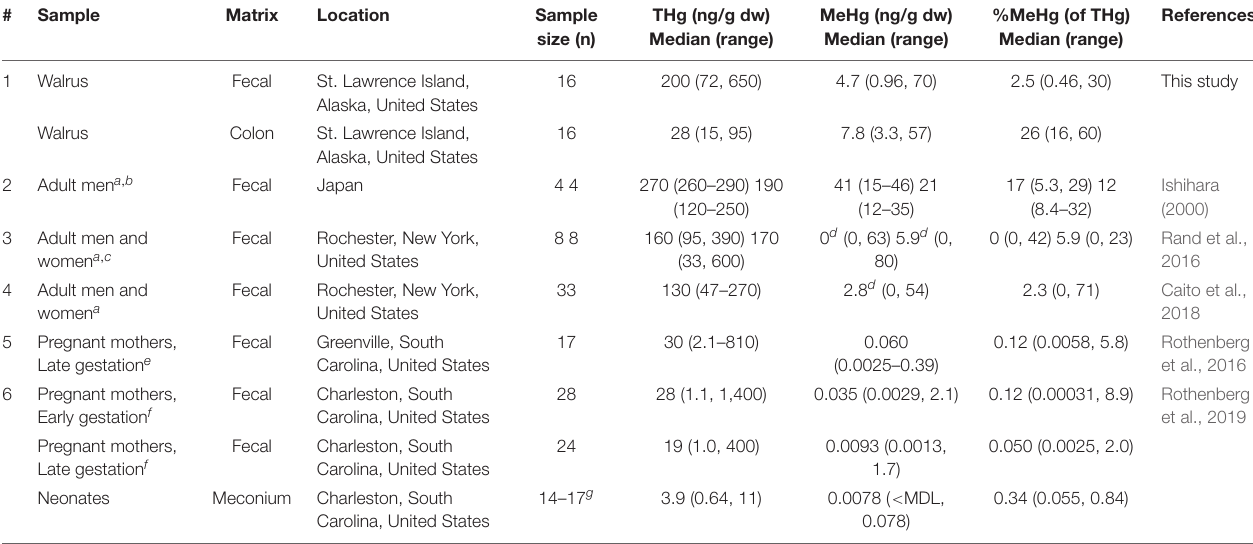
TABLE 5 | Comparison of fecal (or colon) mercury concentrations between walruses and